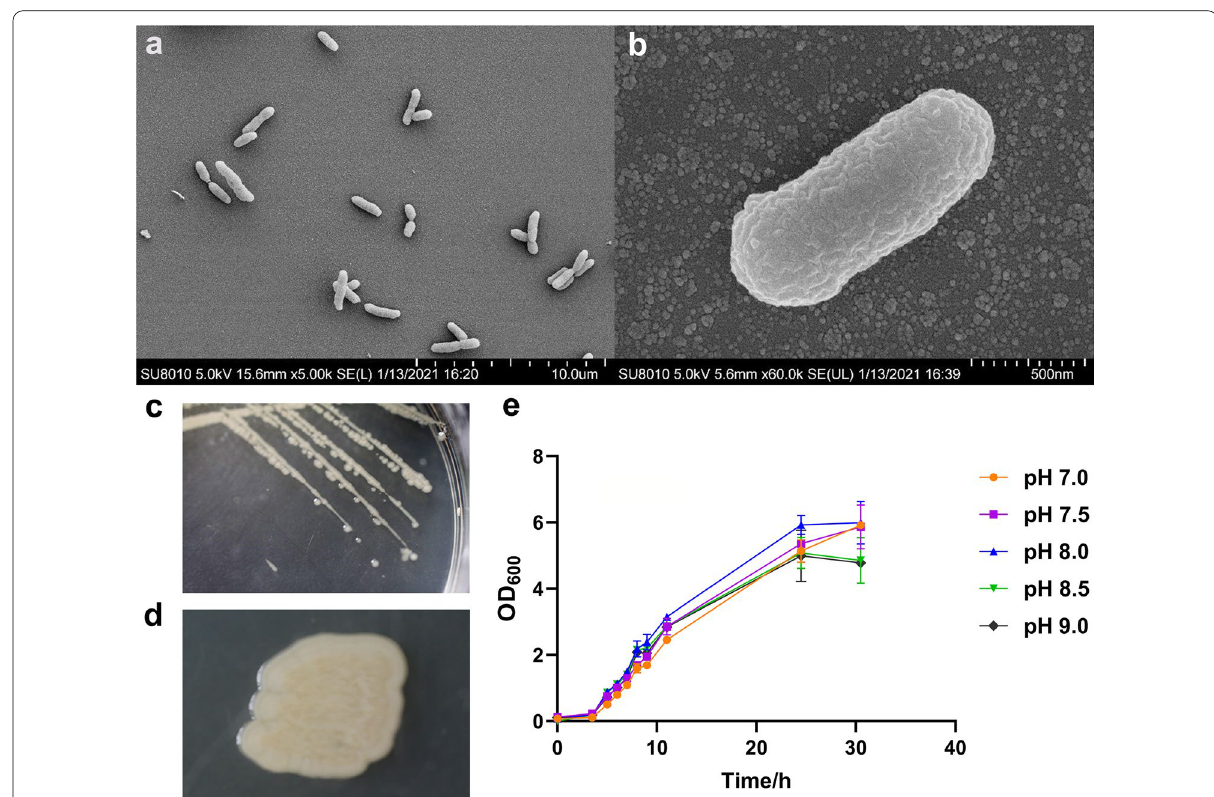
Fig. 2 Morphology and physiological characteristics of Halomonas salifodinae IM328. Cell morphology of IM328 visualized using a transmission electron microscope ( a, b ), colony morphology on solid medium ( c, d ), and growth curve in media of different pH values ( e ), respectively. IM328 was cultured in LB-60 medium for determining the optimal growth pH by adding 25 mM MOPS (pH 7.0), HEPES (pH 7.5), Tricine (pH 8.0 and 8.5), and CHES (pH 9.0) at 37 °C, 200 rpm. These data were mean values, and standard errors were calculated from three parallel